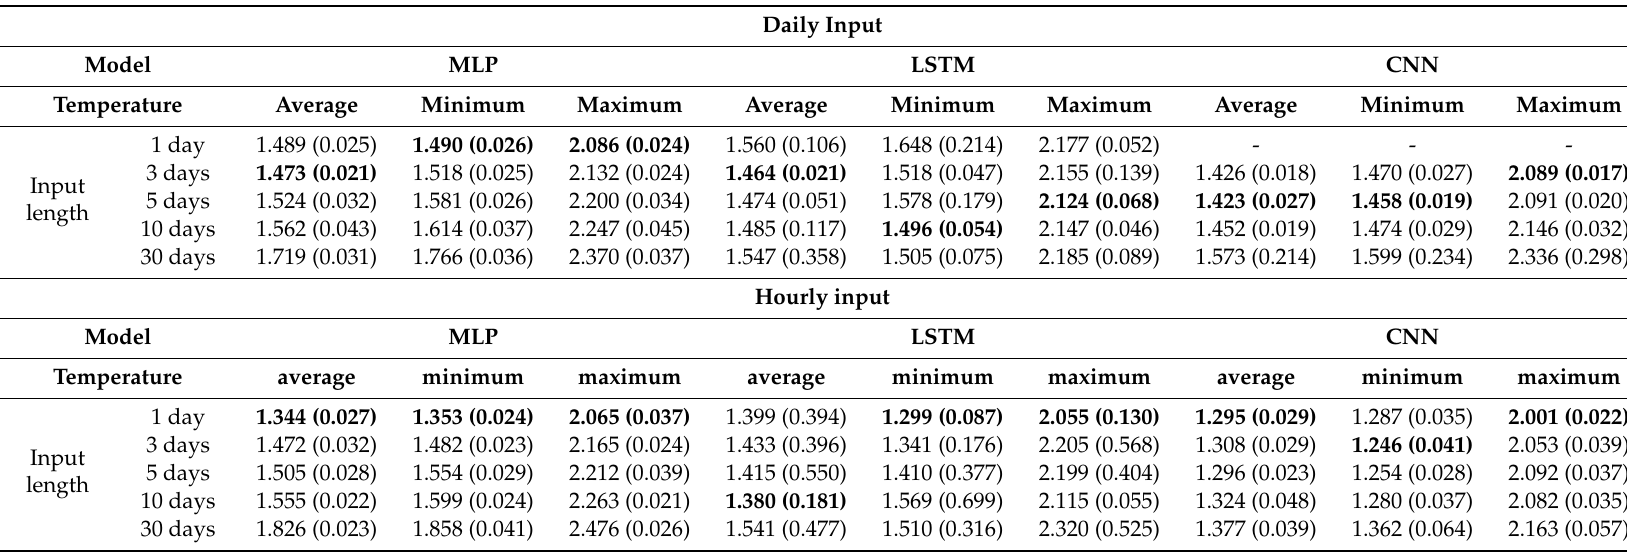
Table 15. Forecasting results, represented using the mean absolute error (MAE), for metropolitan area (Seoul).